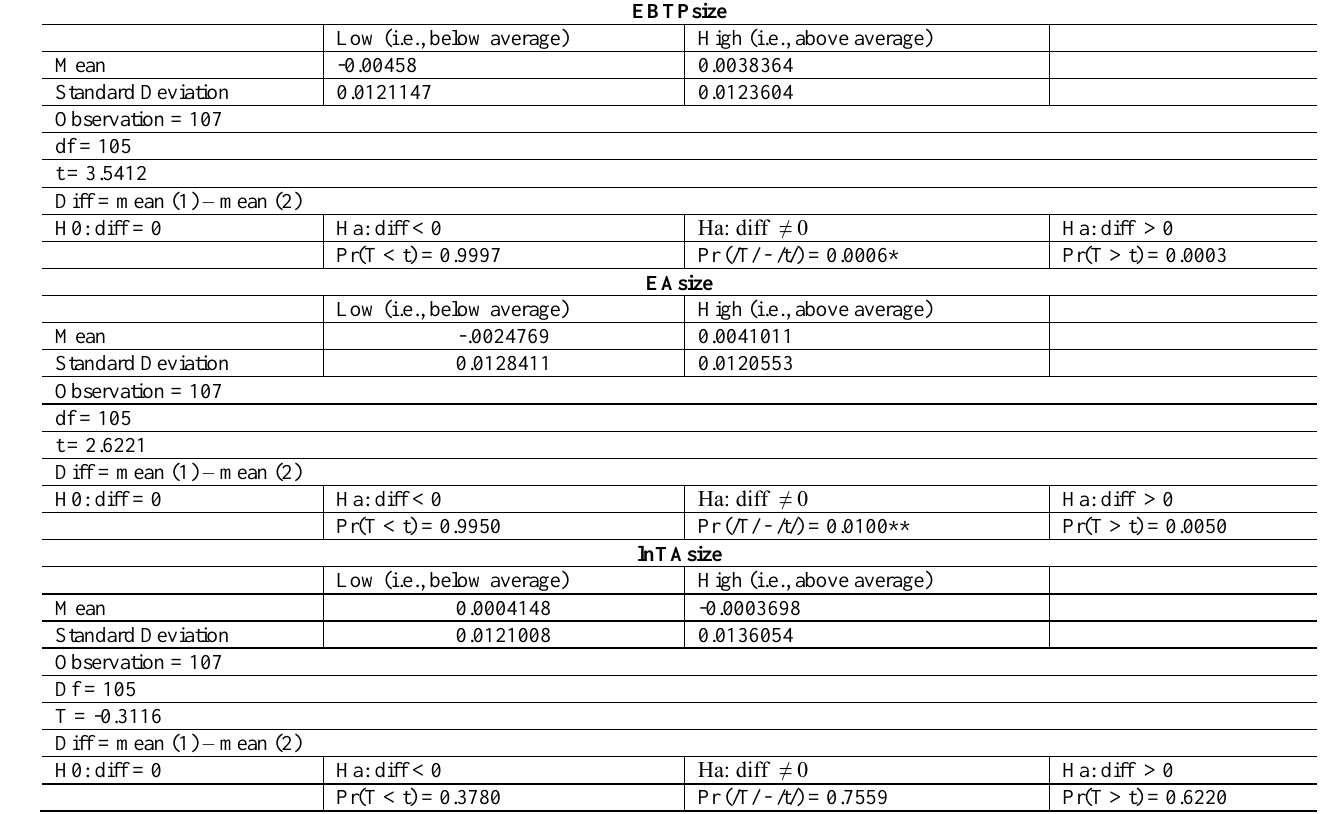
EBTPsize High (i.e., above